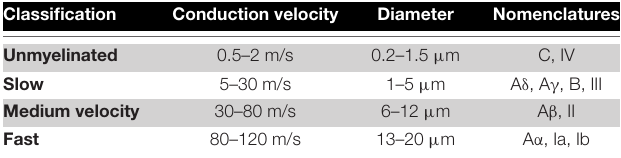
TABLE 1 | Fiber classification based on conduction velocity used in this publication [compiled from Purves et al. (2012) and Parker et al.